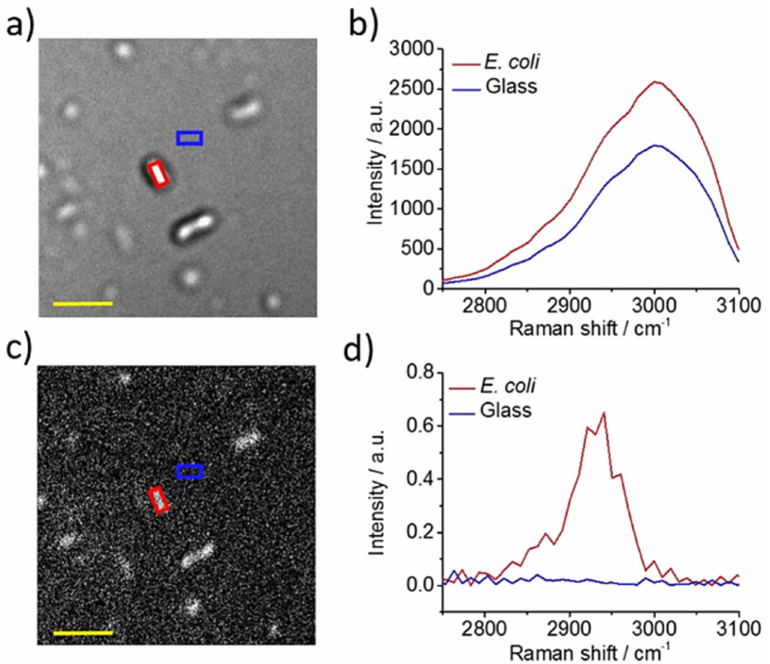
Figure 6. In situ detection of single bacteria in complex environments by hyperspectral CARS imaging. ( a ) Hyperspectral CARS image of concentrated E. coli culture liquid dropped on glass. ( b ) Corresponding hyperspectral CARS profiles of E. coli and glass background. ( c ) CARS image after phase retrieval. ( d ) Corresponding phase-retrieved CARS spectra of E. coli and glass background. Scale bar: 5 µ m. Reprinted from reference [51] with